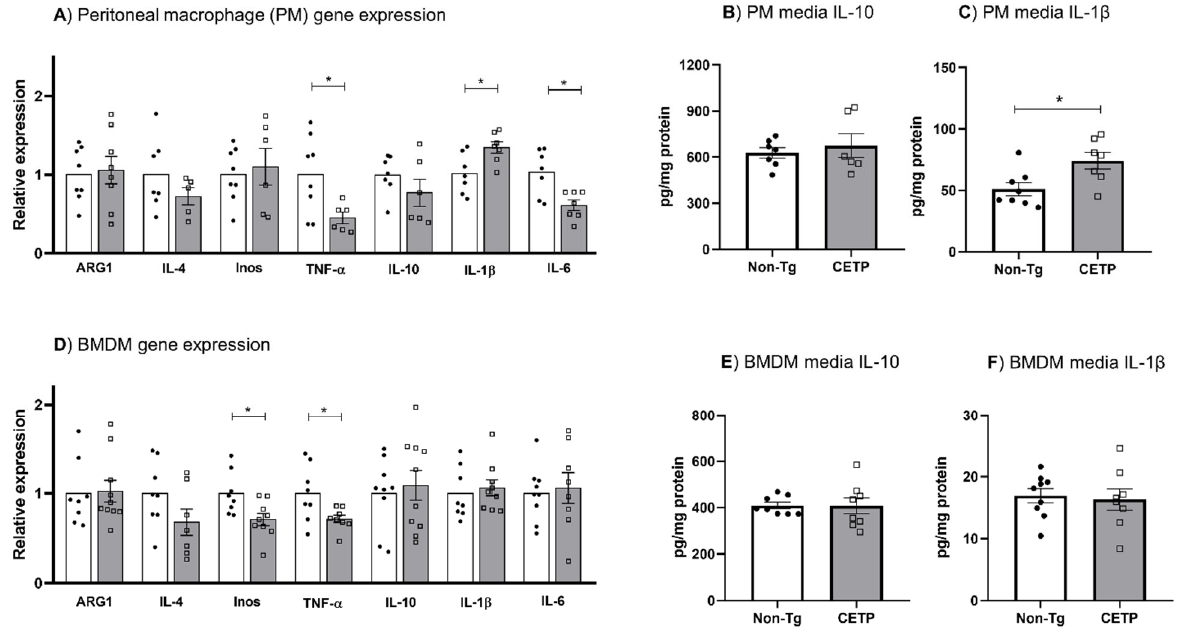
Figure 4. Effects of CETP expression in macrophages on inflammatory related genes and cytokines secretion. Gene expression ( A , D ) and IL ‐ 10 and IL ‐ 1 β media secretion ( B , C , and E , F ) in thioglycolate ‐ elicited peritoneal macrophage ( A − C ) and in bone marrow derived macrophage